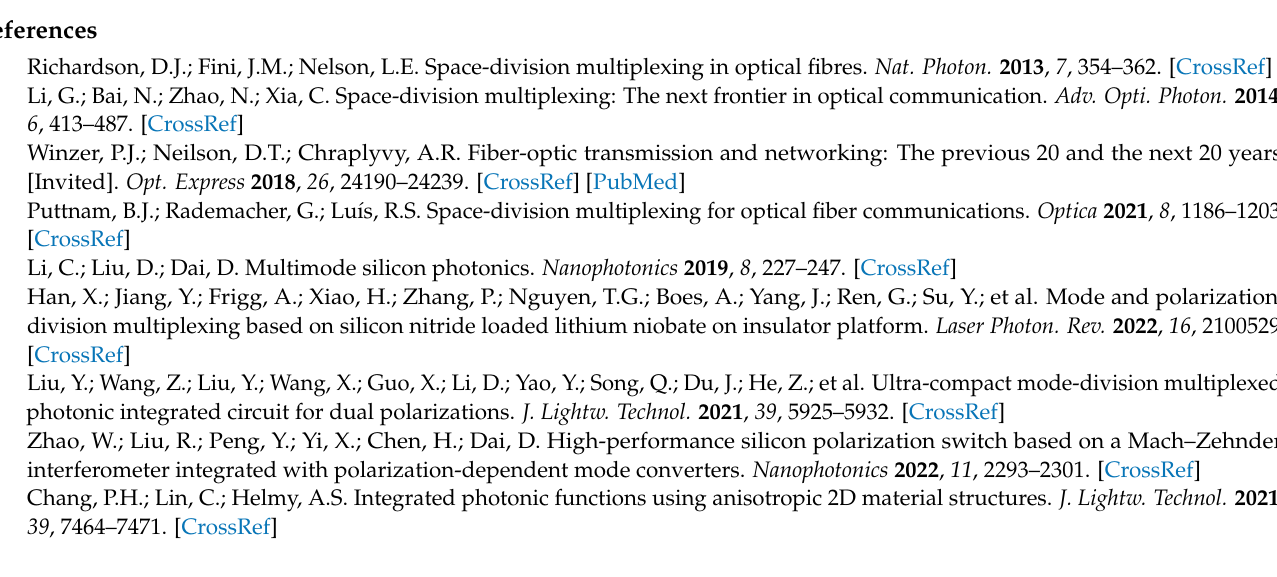
In this paper, we propose a mode switch based on hybrid-core cascaded vertical DCs. Three GEHs are designed on the top of three vertical DCs, which are formed with an FMC and three SMCs. Such a device can realize modal switching for the E 21 , E 12 and E 11 mode by applying various electric power to three GEHs. The maximum power consumptions for three GEHs are approximately 3.19 mW, 3.09 mW and 2.97 mW, respectively. The response times are shorter than 495 µ s, 486 µ s and 498 µ s. The CRs for three modes are higher than 99.1%, 90.8% and 97.3% over the C-band. Moreover, our proposed device also shows great potential for the DMG equalization of FM-EDFA during the long-distance MDM